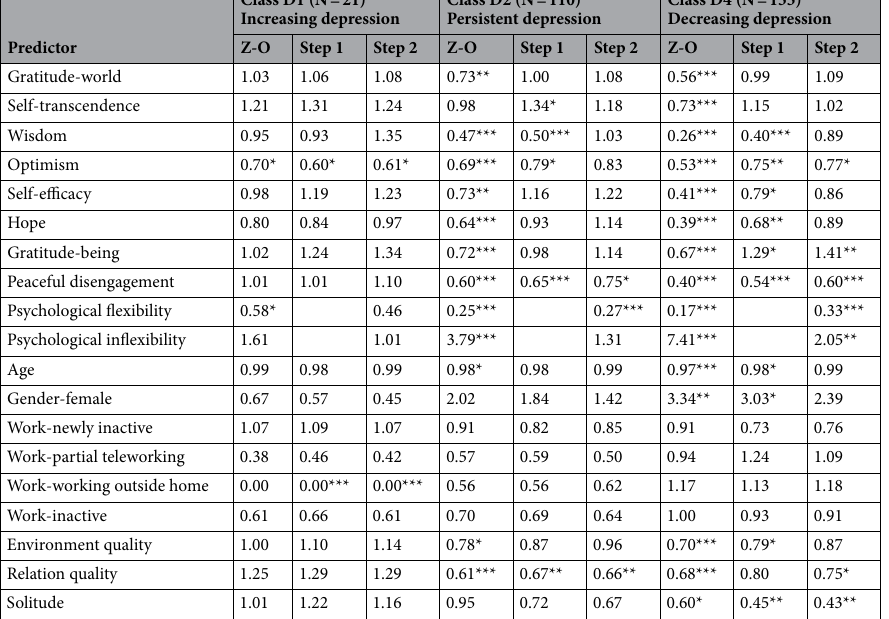
Table 5. Odds ratios of being in the depression symptomatology classes (Classes D1, D2, and D4) versus being in the no depression symptomatology class (D3) depending on psychological resources (Step 1) and psychological flexibility (Step 2), controlling for sociodemographic variables. Values in Step 1 and 2 columns are the odds ratios from the multinomial regression models predicting membership of the depression classes against no depression symptomatology class as the reference group (Class D3). The Z-O column gives the variable zero-ordered effects, with other variables not included in the model. p < 0.05, p < 0.01, p <